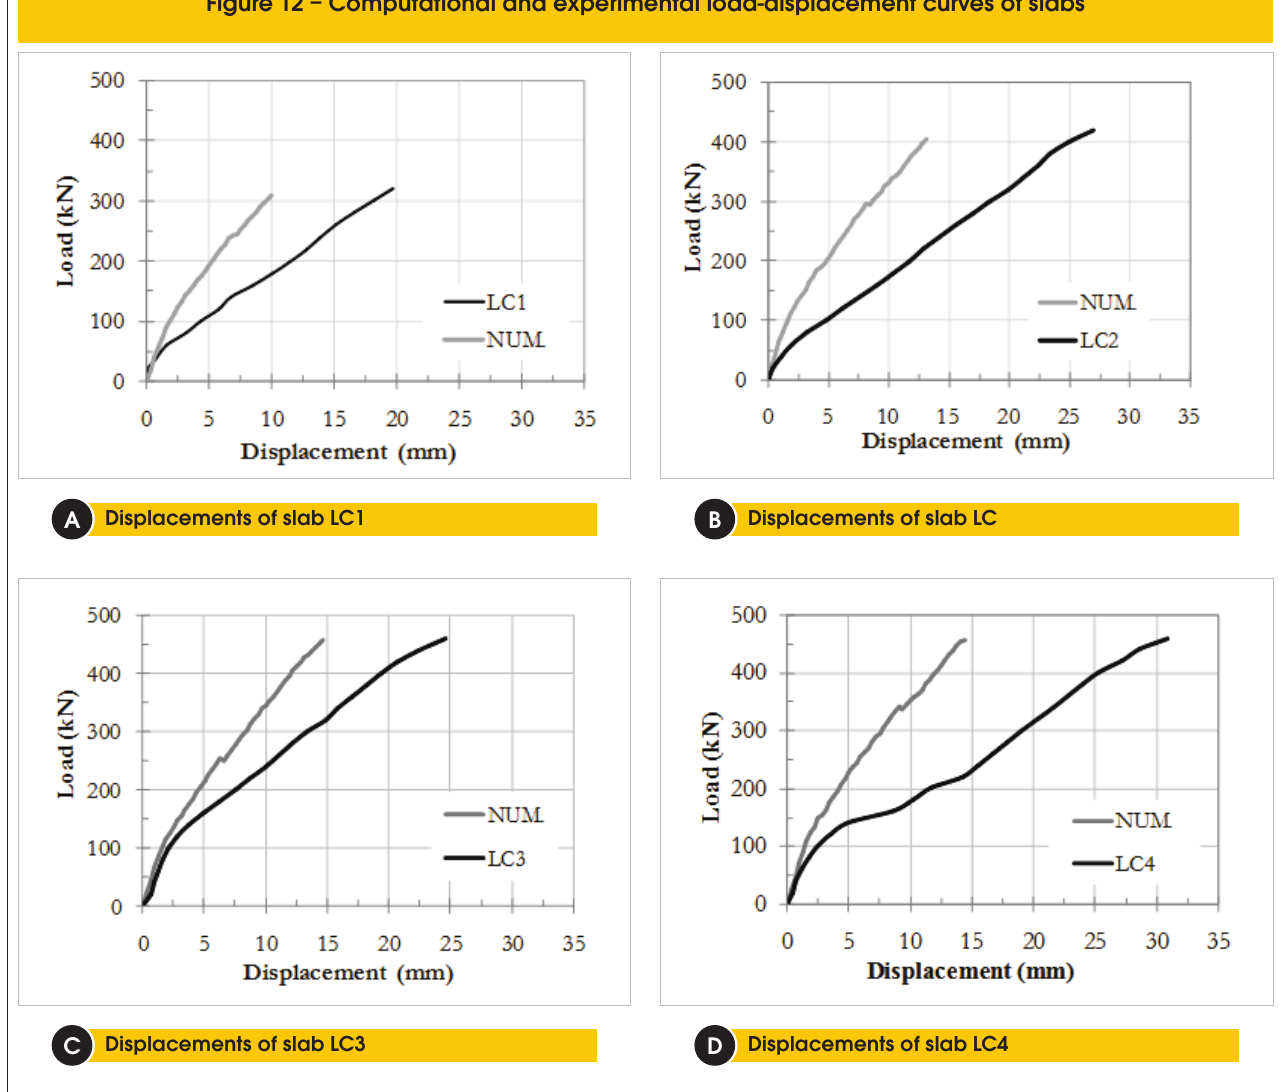
Figure 12 – Computational and experimental load-displacement curves of slabs